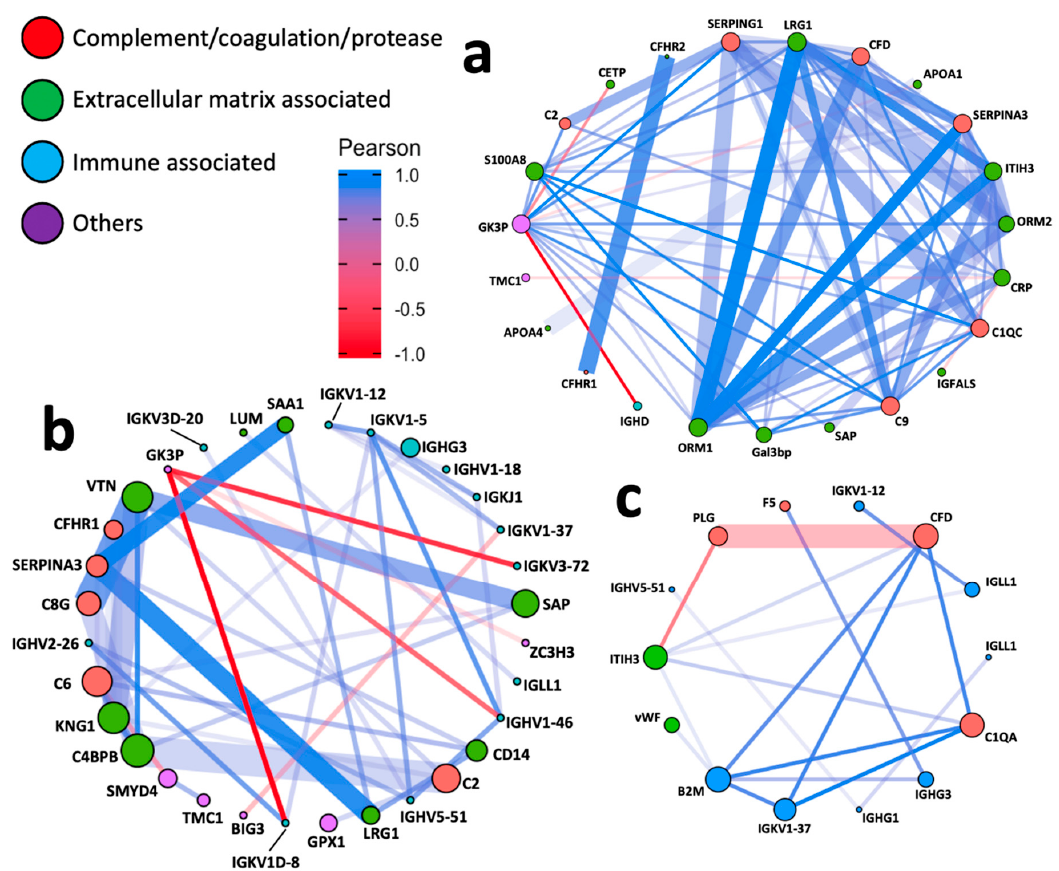
Figure 4. Network analysis. Network plots illustrating protein–protein interactions in ( a ) acute HFpEF vs. HCM, ( b ) chronic HFpEF vs. HCM and ( c ) acute vs. chronic HFpEF. Each node represents one protein; and each edge represents a pairwise Pearson correlation between proteins. The networks only show Pearson correlation coefficient > 0.7 or < − 0.7. Node: colour coded according to the functional classification of proteins annotated by DAVID; size proportional to the corresponding eigenvector centrality (network influence). Edge: colour and length proportional to the Pearson correlation coefficient; width proportional to the scores derived from STRING database.